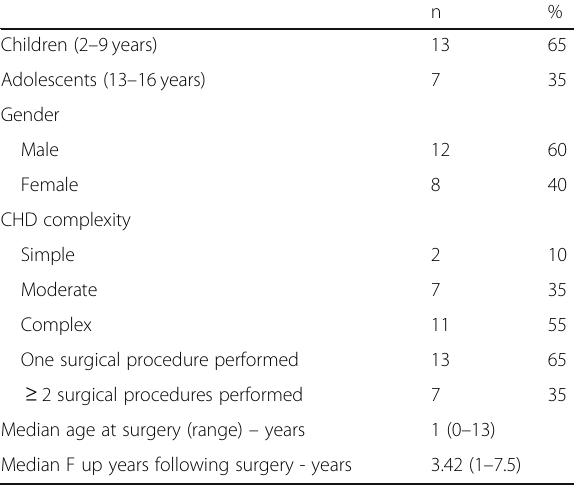
Table 2 Characteristics of the CHD